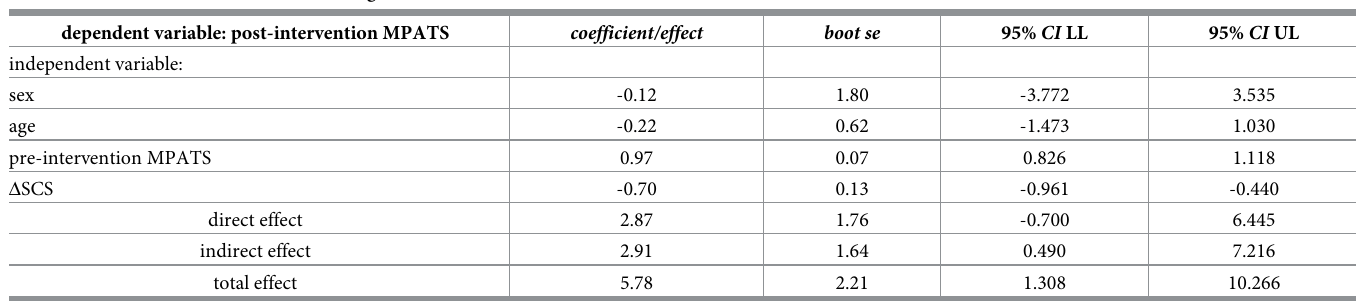
Table 4. Summaries of PROCESS mediating effect